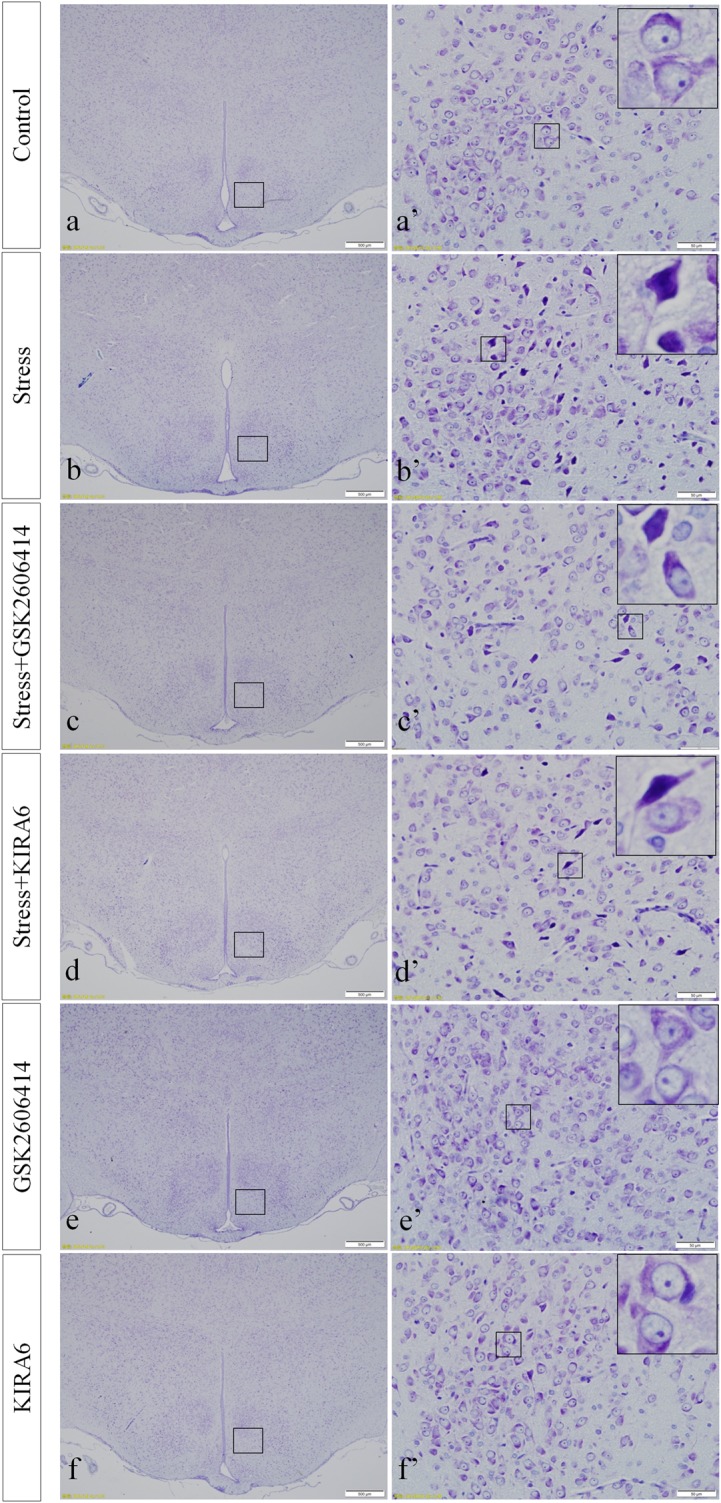
Thionine staining of the hypothalamus. (a’–f’) are magnified areas of (a–f), respectively. High-power photomicrographs in the right corners of (a’–f’) are enlarged from rectangles in the low-power photomicrographs. Bars = 500 μm in (a–f); Bars = 50 μm in (a’–f’).